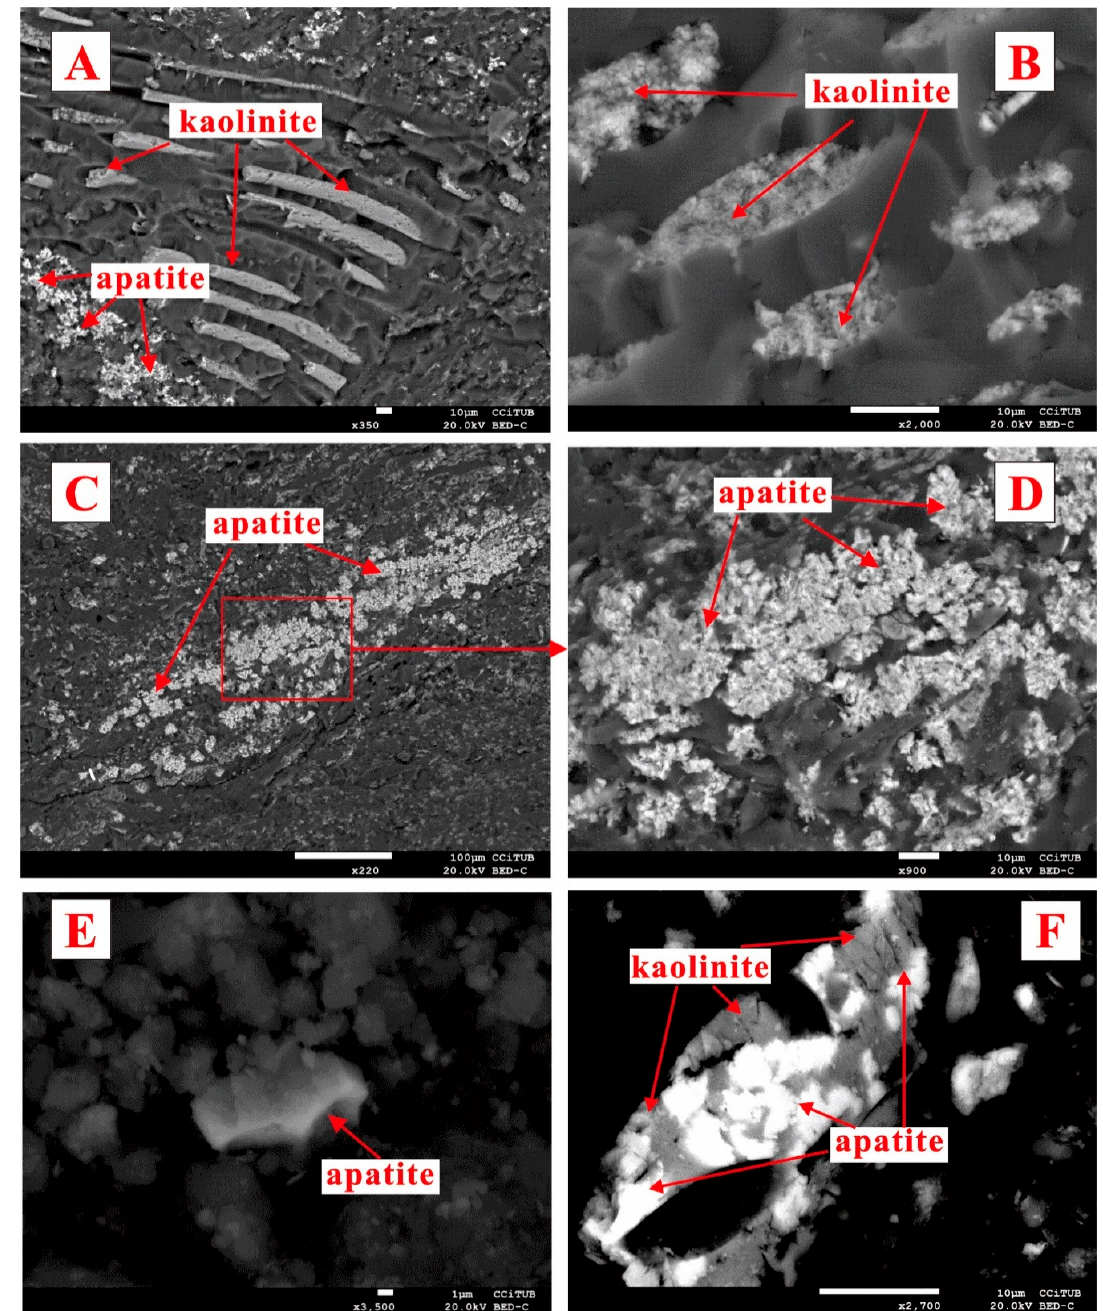
Figure 6. SEM back-scattered images of kaolinite and apatite (sample PR 4-5-P). ( A , B ) cell-filling kaolinite; ( C , D ) syngenetic cell or pore space infillings apatite; ( E ) dispersed apatite particles within organic matter; ( F ) the growth of kaolinite and apatite.